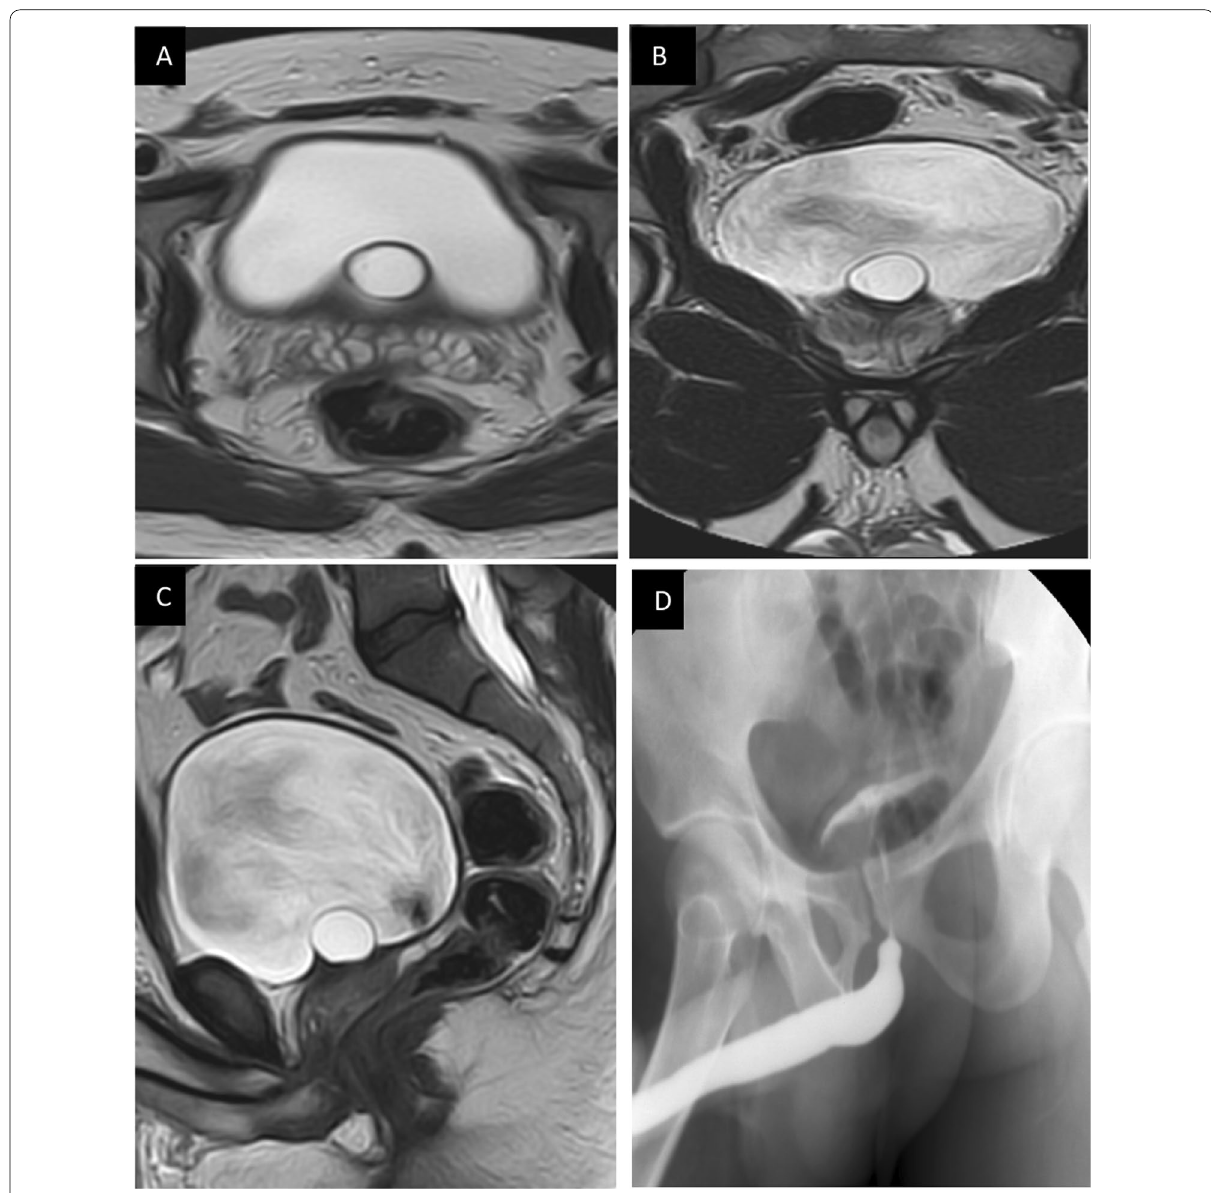
Fig. 2: 3 T. MRI of the pelvis: axial ( A ), coronal ( B ), and sagital ( C ). High‑resolution T2W images showing an anteriorly positioned midline prostatic cyst measuring (1.4 1.1 cm) projecting at the bladder base and neck, ( D ) conventional retrograde ascending urethrogram showing normal × contrast opaciication of the whole urethra with non filling or opaciing of the cyst confirming the non communication with the